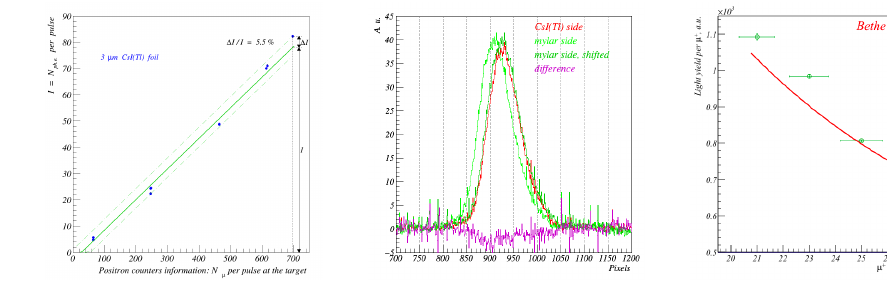
Figure 3. Linearity of the 3 µ m foil.